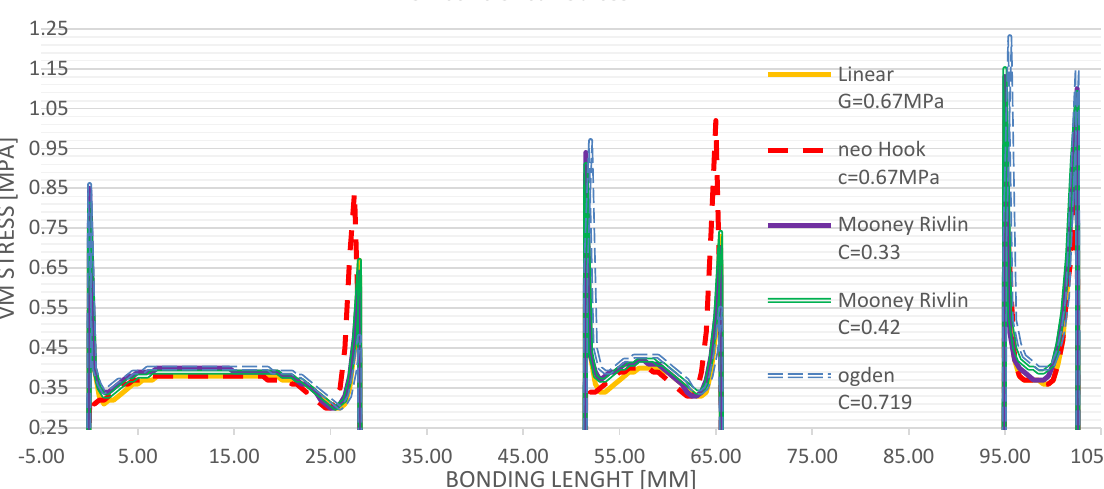
Graph 4 Shear stress (peak nodal stress), Left results for 4:1 aspect ratio, Middle results for 2:1 aspect ratio, Right results for 1:1 aspect